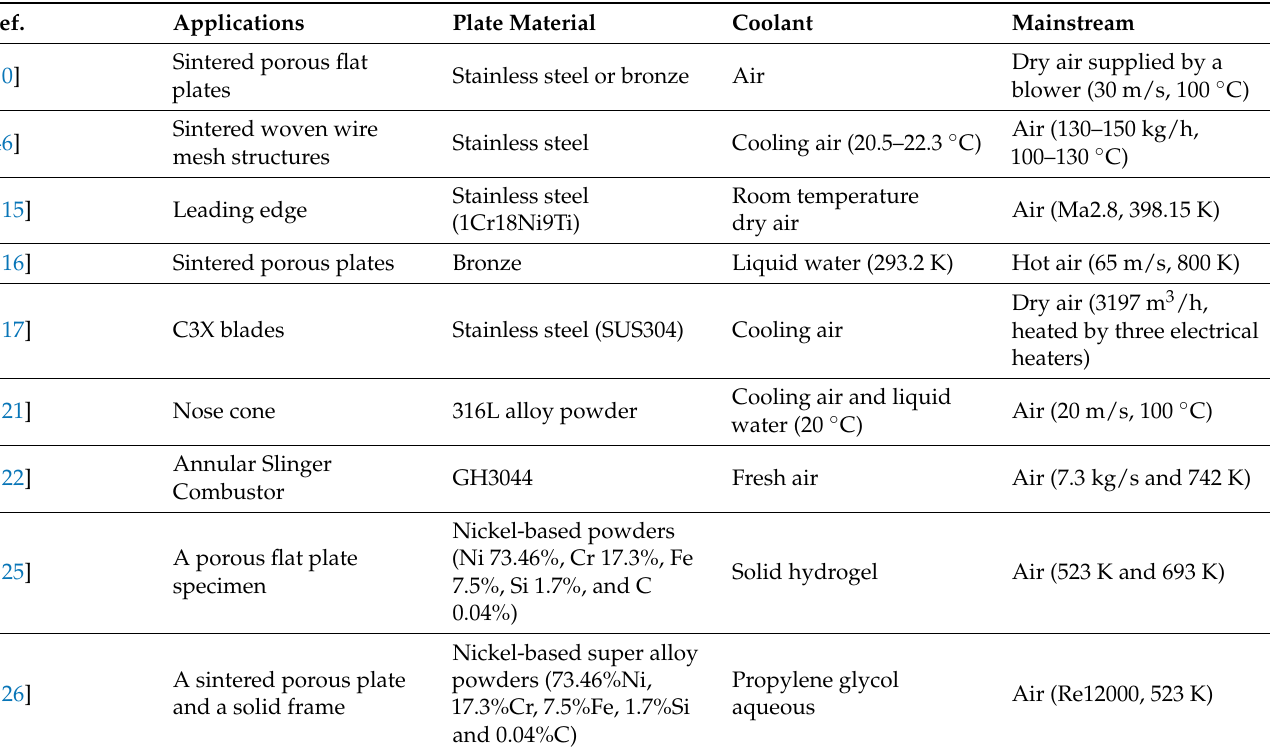
Figure 10. Schematic of transpiration cooling in nose cone regions. Reprinted/adapted with permission from Ref. [121] . 2019, Elsevier Inc. Table 3. Literature on different applications used in transpiration